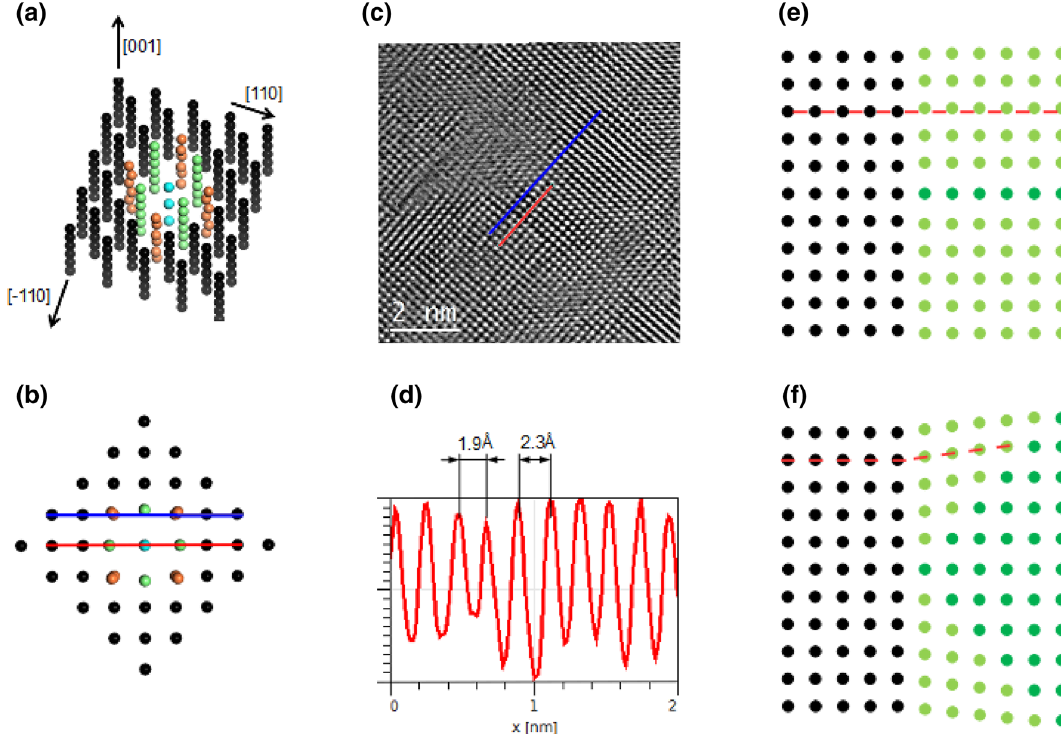
Figure 6. ( a , b ) Model containing a sequence of nickel vacancies along the [001] direction. Vacancies are within the blue column. The columns which experience significant relaxation due to the vacancies are depicted in green and orange. The relaxation—taken from the DFT calculation—is visualised in ( b ), which is a (001) plane. Red and blue lines in ( b ) illustrate the variation in the lattice constant and the bending of a lattice fringe induced by the vacancies. These predicted inhomogeneities are comparable to experiment; In ( c ) the blue line highlights an example of the bending of a lattice fringe, while ( d ) is the line profile corresponding to the red line in ( c ) and illustrates the variation in the lattice constant. ( e ) The dark green row represents a line (or plane out of the page) containing ordered nickel vacancies. The relaxation of adjacent rows (or planes) results in the decoherence of the light green and black regions, similar to an edge dislocation highlighted by the red-dashed line. ( f ) The triangular network of vacancies results in the light green and black regions being misorientated with respect to each other, highlighted by the red-dashed